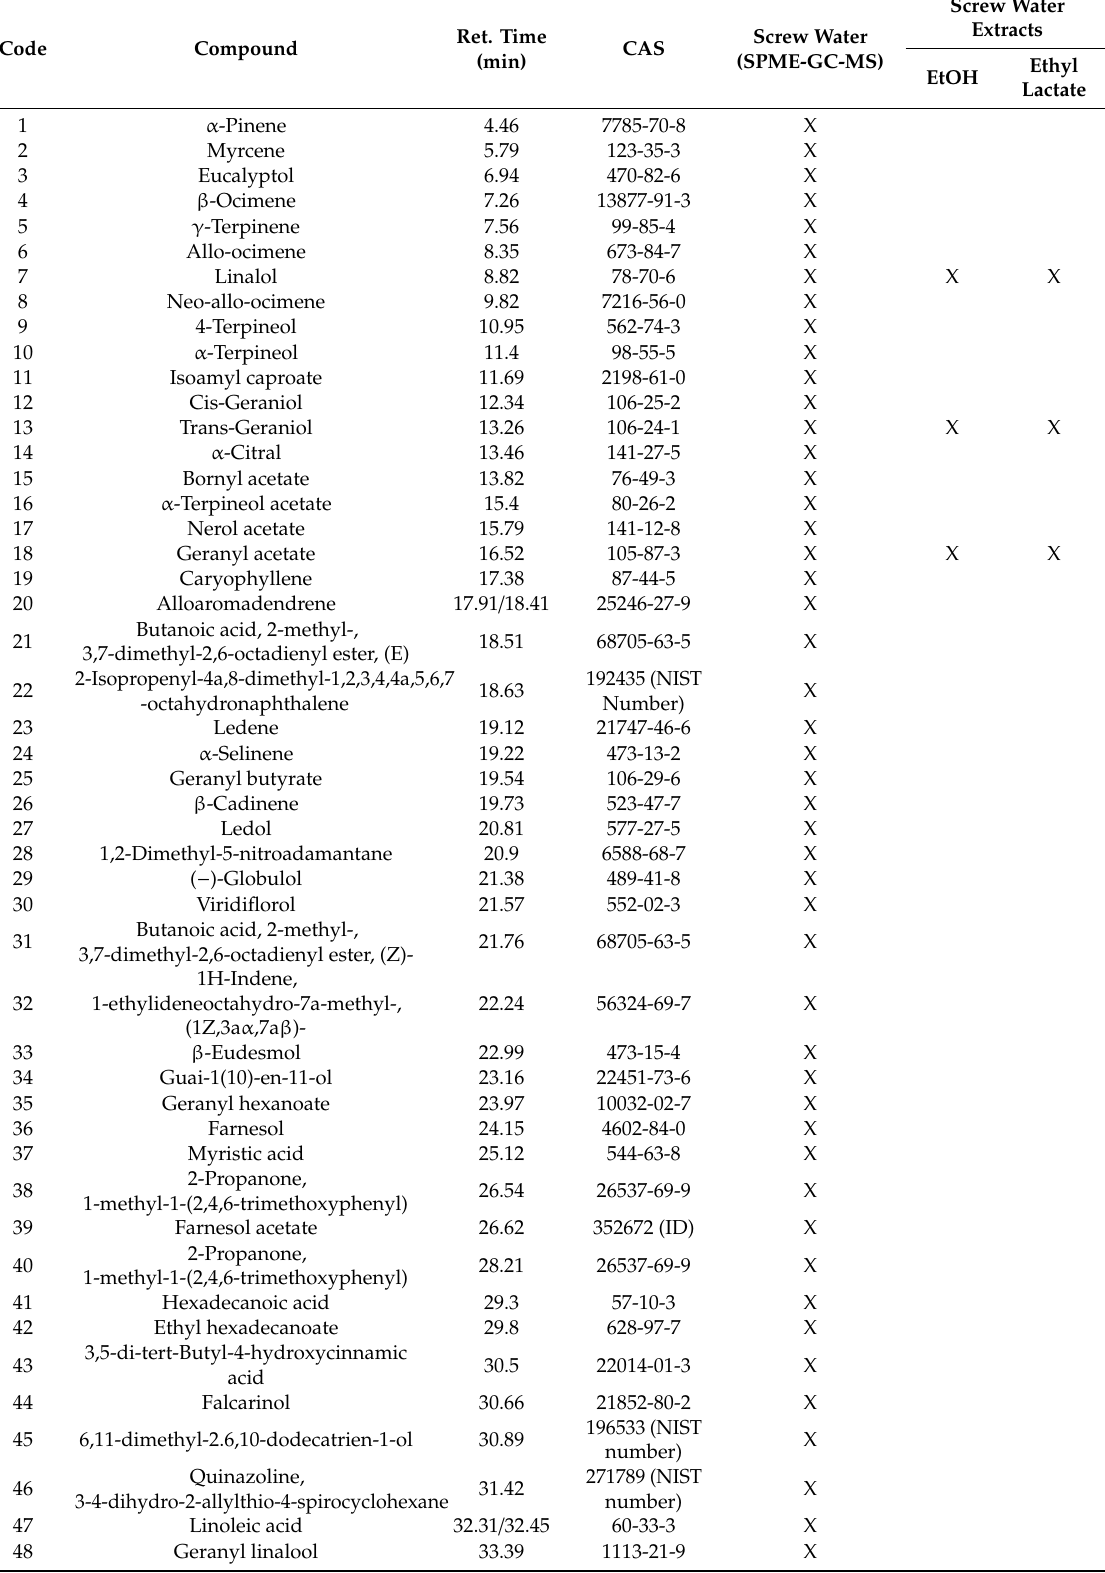
Table 2. Identified compounds in the Eucalyptus screw water (SPME-GC-MS analysis), and in its derived organic extracts